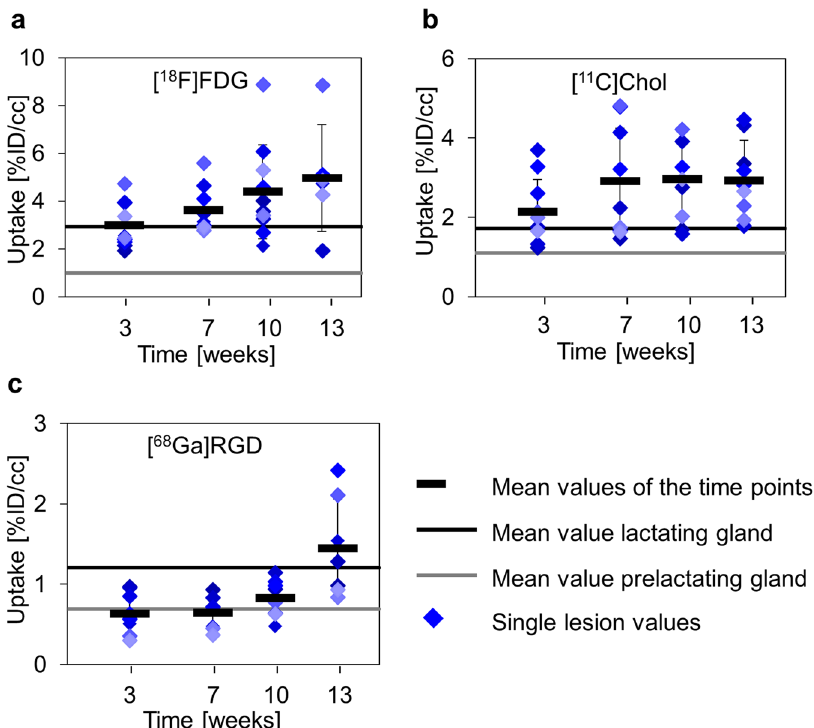
Fig. 3 Mean value analysis of tracer uptake. Mean values (black bars) ± standard deviation, as well as single values, for every lesion ( fi lled diamonds) of the investigated tracer were plotted over time and compared to prelactating (gray line) and lactating (black line) mammary glands. a [ 18 F]FDG uptake showed a steady increase in uptake from w3, starting at the level of the lactating glands to w13. b [ 11 C]Chol showed a slight increase from w3 to w7 and a stable mean value from w7 until w13. c [ 68 Ga]RGD uptake was observed in the range of the prelactating glands from w3 to w10 and increased from w10 to w13. A statistically signi fi cant difference between MIN-O lesions and pre- or lactating glands was not observed for any of the